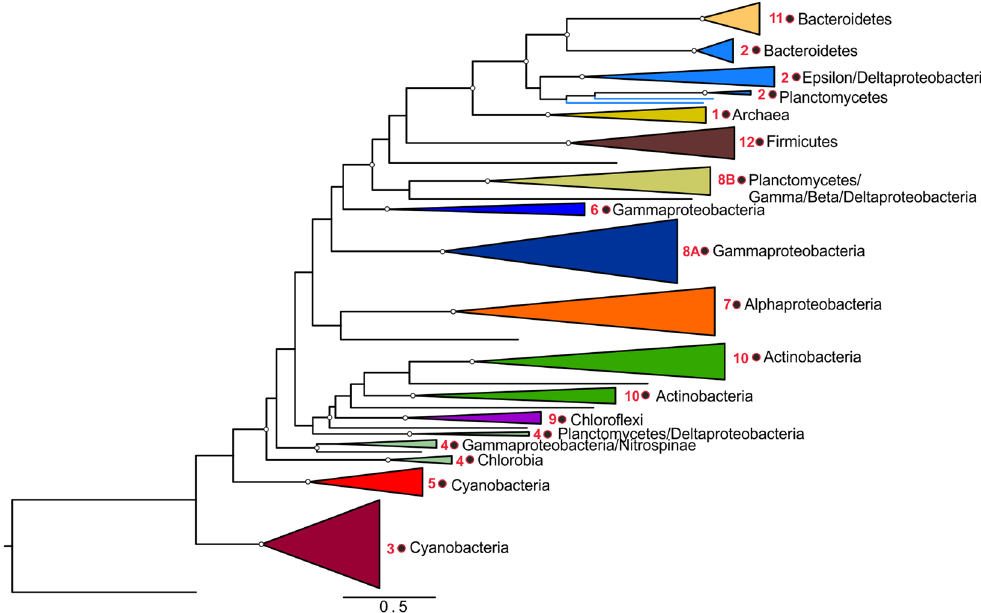
Figure 3. Phylogenetic tree of Cas1 associated with RTs. The phylogenetic reconstruction was carried out with 148 Cas1 proteins. The identified clades were named and colored according to the RT-associated clade. FastTree support values ≥ 0.92 are indicated at the nodes. The Cas1 protein (unknown subtype) from Arthropira platensis (GI:479129287) 21 was used as an